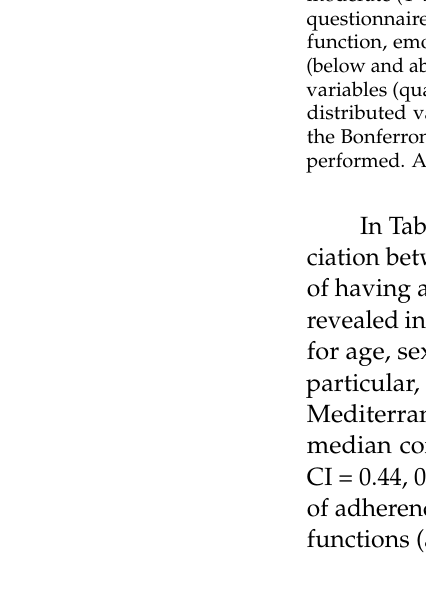
Table 3. Logistic regression models evaluating the association between level of adherence to the Mediterranean diet and parent-perceived quality of life of students at baseline ( n =